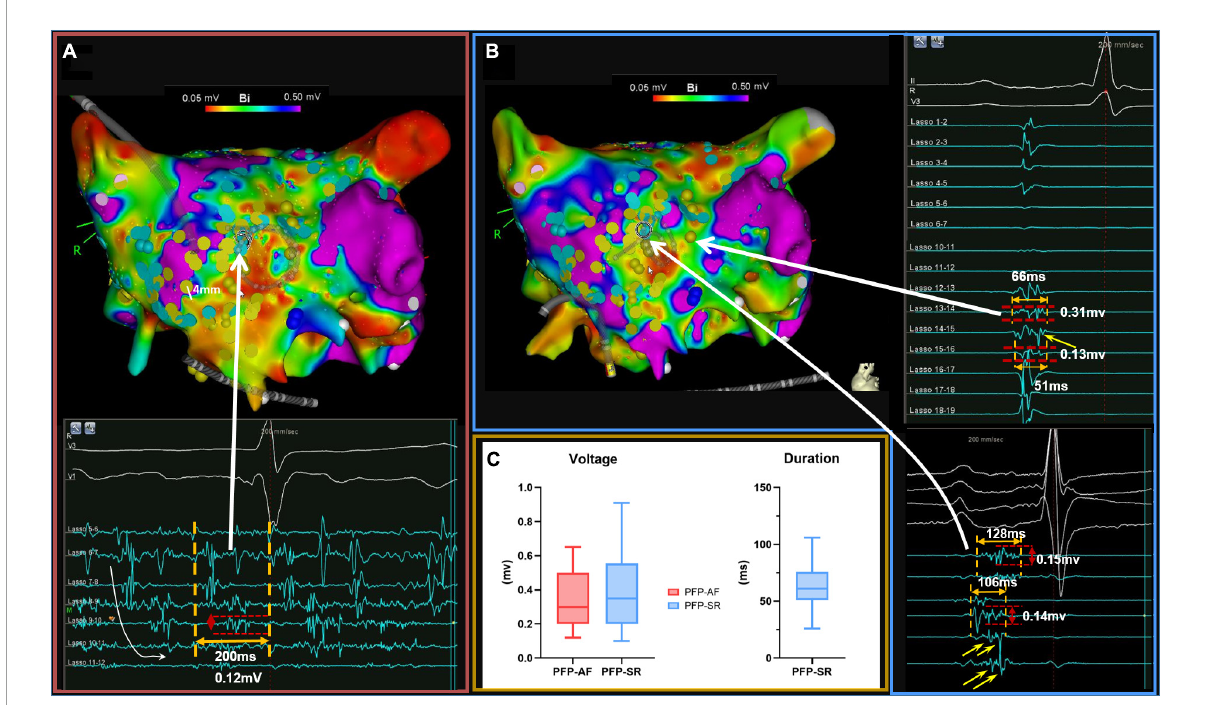
FIGURE1 Illustration of PFP-AF and PFP-SR. (A,B) Illustrate voltage mapping during AF and SR, respectively. A bipolar threshold of 0.5 mV was adopted in both maps to identify LVA. Mapping points presenting PFP-AF and PFP-SR are annotated in light blue and yellow, respectively. Panel (A) illustrates electrogram examples of PFP-AF and panel (B) examples of PFP-SR. PFP-AF is defined as electrograms with prolonged activity lasting ≥ 70% local AF cycle length (Lasso 8–9 and 9–10) on a single or on multiple consecutive bipoles, with high-temporal consistency (8/10 consecutive AF beats with an electrogram “observation period” of 15 s at the same location. The curved white arrow illustrates spatio-temporal dispersion on Lasso 5–6 to Lasso 10–11). PFP-SR is defined as electrograms with ≥ 5 deflections or electrograms with a delayed electrogram component following a first depolarization event on a single bipolar recording in SR. Characteristic delayed electrogram components of PFP-SR are illustrated with yellow arrows in panel (B) . (C) Depicted the electrophysiological characteristics of PFP-AF (red) and PFP-SR (blue). Voltage and duration are expressed as median, 25th and 75th percentiles. PFP, prolonged fractionated potential; AF, atrial fibrillation; SR, sinus